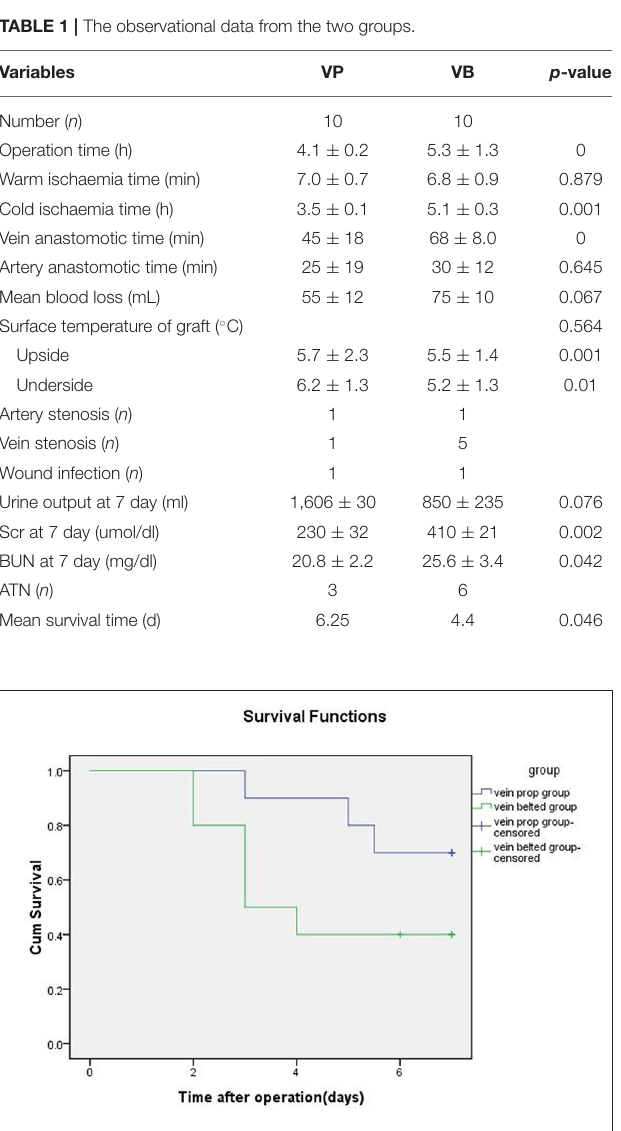
represent the best technique for kidney